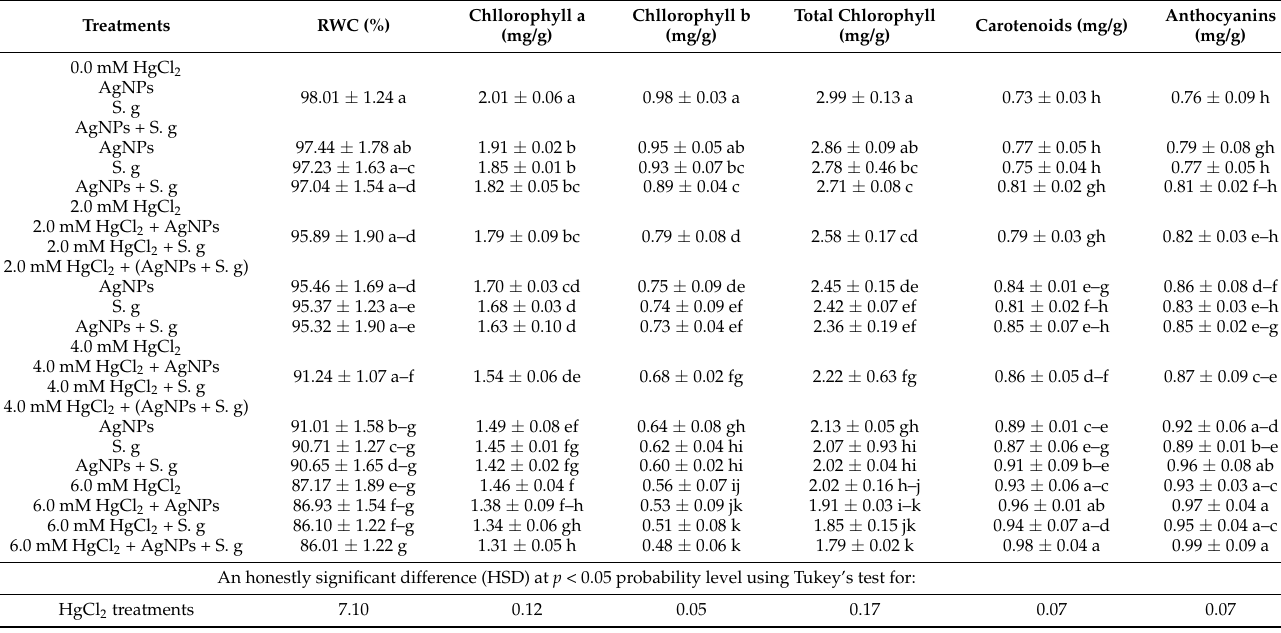
Table 2. The effect of AgNPs, Sphingobacterium ginsenosidiumtans (S. g), and their combination on relative water content (RWC), chlorophyll a, chlorophyll b, total chlorophyll, carotenoids, and anthocyanins pigments of Trigonella foenum-gracum L. plants under HgCl 2 (0, 2, 4, and 6 mM). Treatments RWC (%) Chllorophyll a (mg/g) Chllorophyll b (mg/g) Total Chlorophyll (mg/g) Carotenoids (mg/g) Anthocyanins (mg/g)